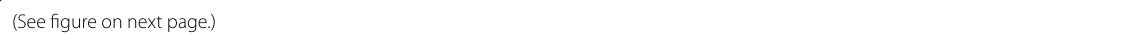
event on January 24, 2012 ( upper panel ). Movement of the GPS pierce points (intersections with the ionosphere at 300 km of raypaths between GPS satellite and ground receiver) during the period 1500–1530 UT is shown by a line between two asterisks . Bottom panel the same as in the upper panel , but for Canada. Dark dots denote the geomagnetic projections of the THEMIS and GOES